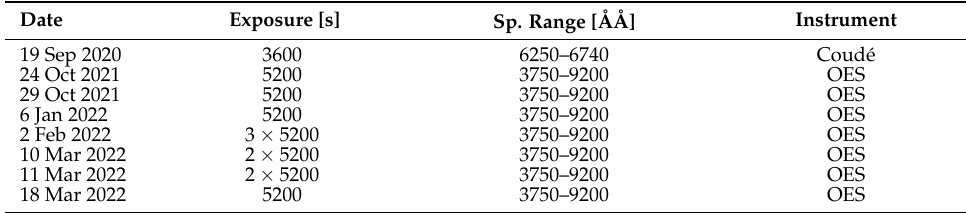
Table 1. Log of HD36030 observations at Perek 2 m